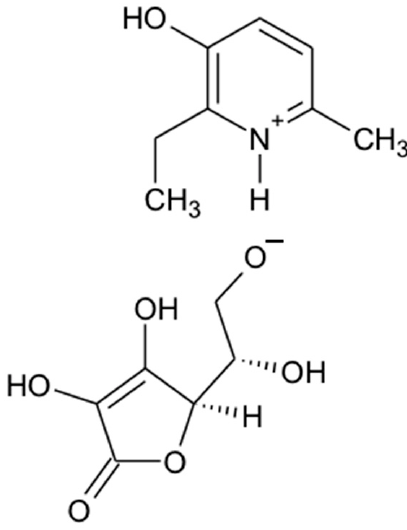
Figure 1. Chemical structure of 2-ethyl-6-methyl-3-hydroxypyridinium gammalactone-2,3-dehydro-L-gulonate (3-EA).